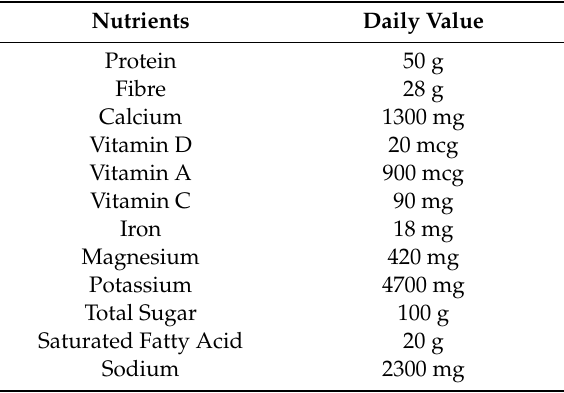
Table 1. The daily values of nutrients in Canada